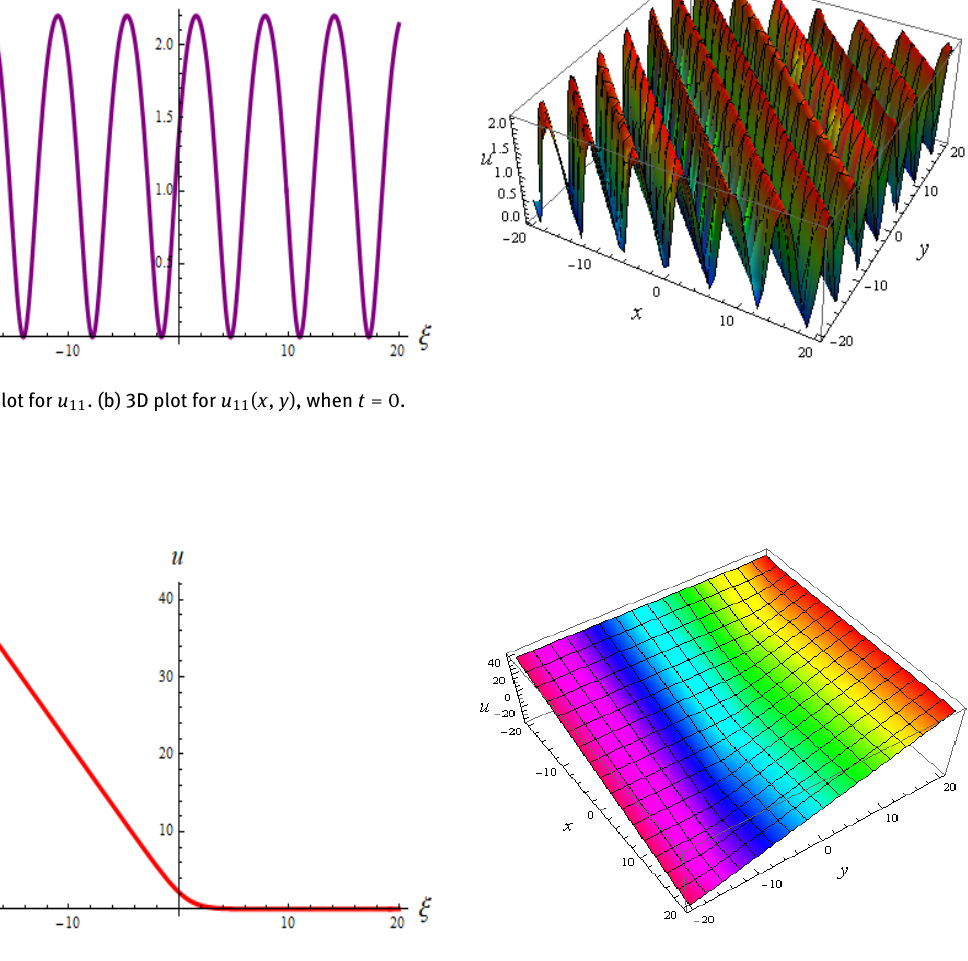
Figure 7: (a) 2D plot for u 10 . (b) 3D plot for u 10 ( x , y ) , when t = 0